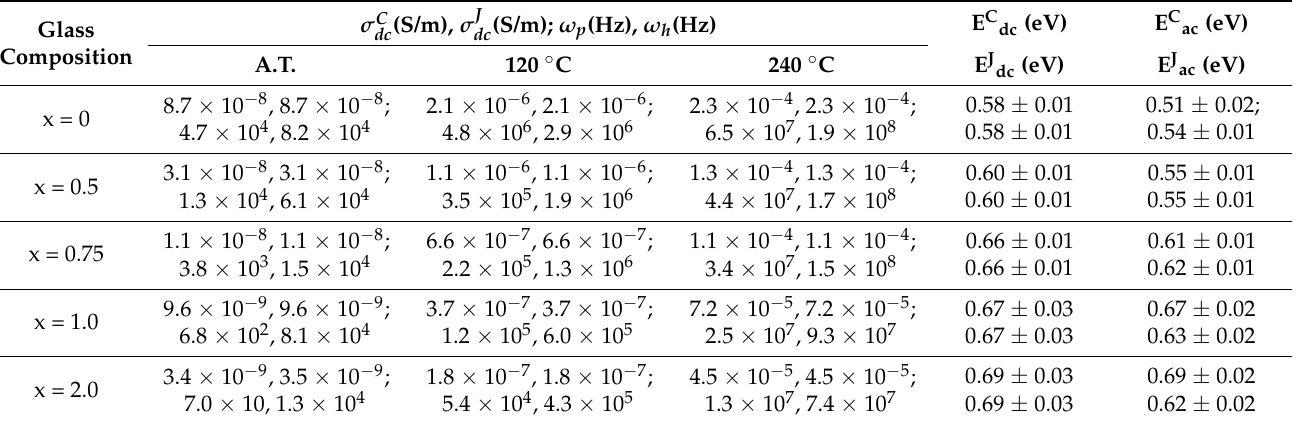
Table 2. Composition and thermal dependent activation energies for the 3Li 2 O-xMn 2 O 3 -(2-x)Fe 2 O 3